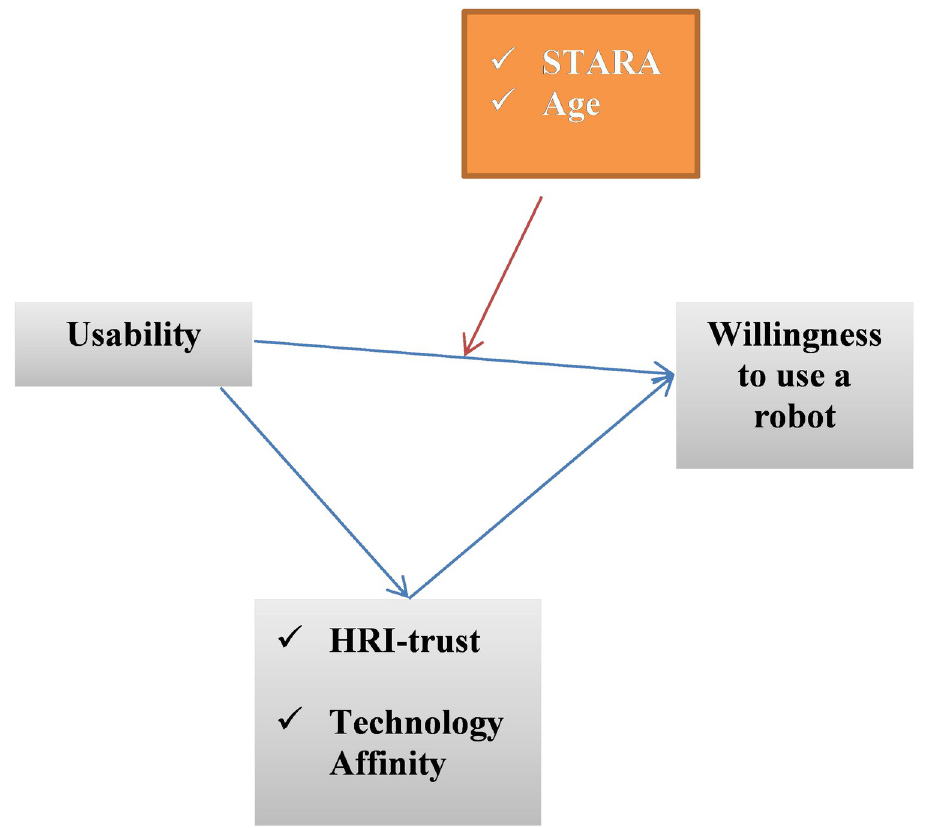
Fig 1. The conceptual model of the current